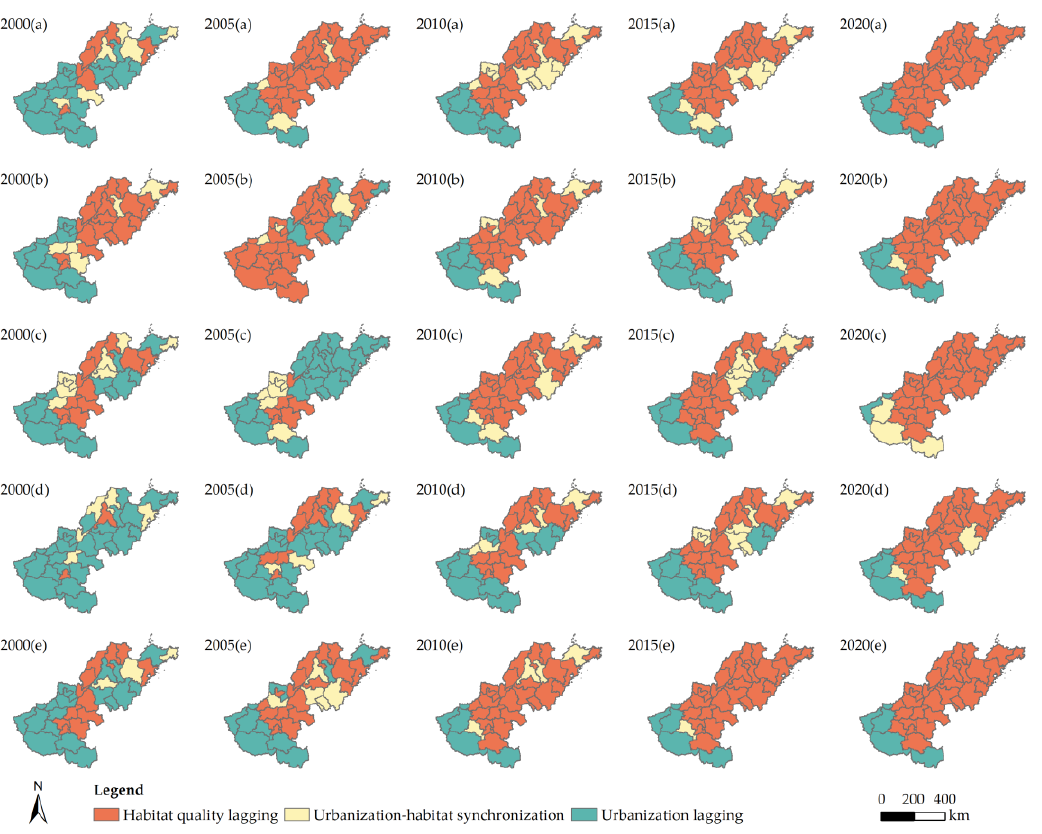
Figure 8. Relative development relationships of the urbanization level and subsystem urbanization level with HQ for each city along the Lower Yellow River between 2000 and 2020: ( a ) urbanization level; ( b ) demographic urbanization level; ( c ) economic urbanization level; ( d ) social urbanization level; ( e ) spatial urbanization level.